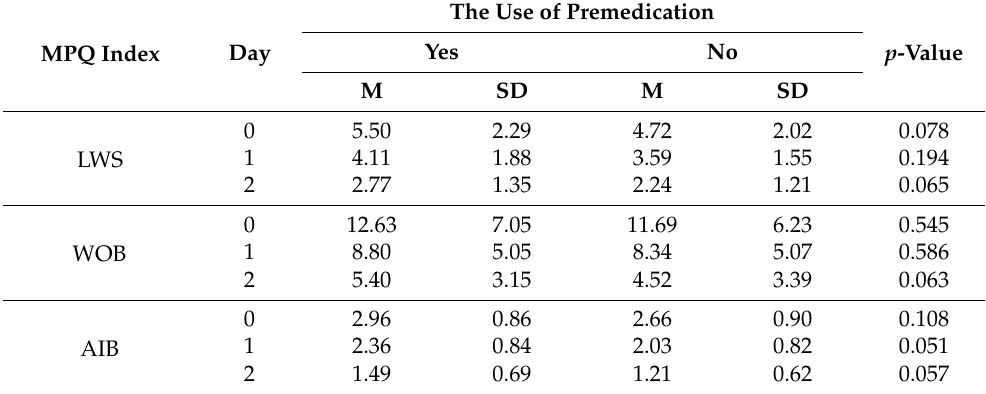
Table 4. The use of premedication and the intensity of pain immediately after the procedure.